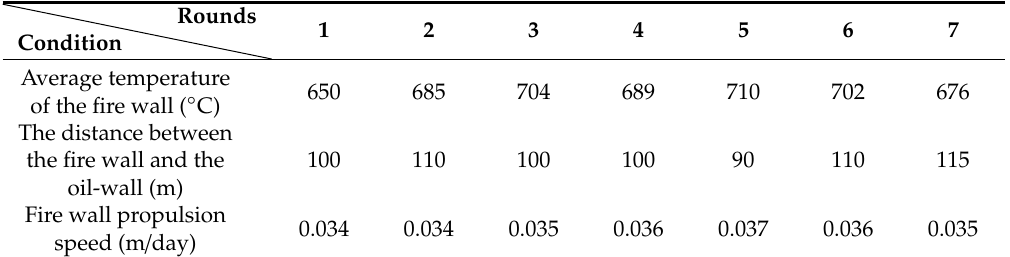
Table 4. Characteristic parameters of the fire-wall under di ff erent hu ff and pu ff rounds.